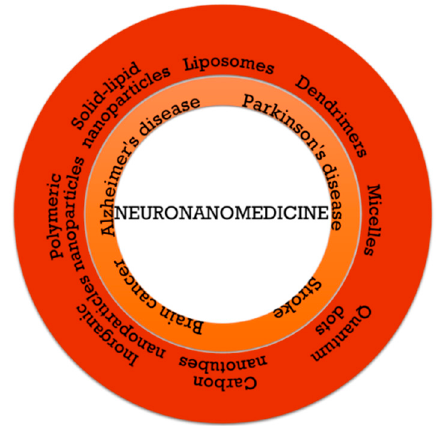
Figure 3. The applications of nanomaterials as nanocarriers in brain cancer, neurodegenerative diseases, and stroke therapy.